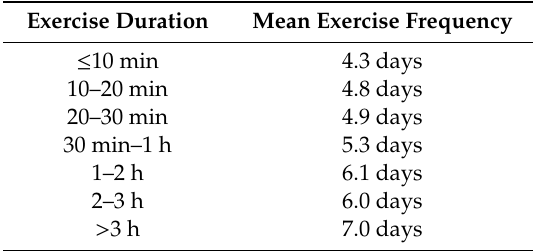
Table 6. Mean exercise frequency of the participants in different exercise duration groups in the green spaces.